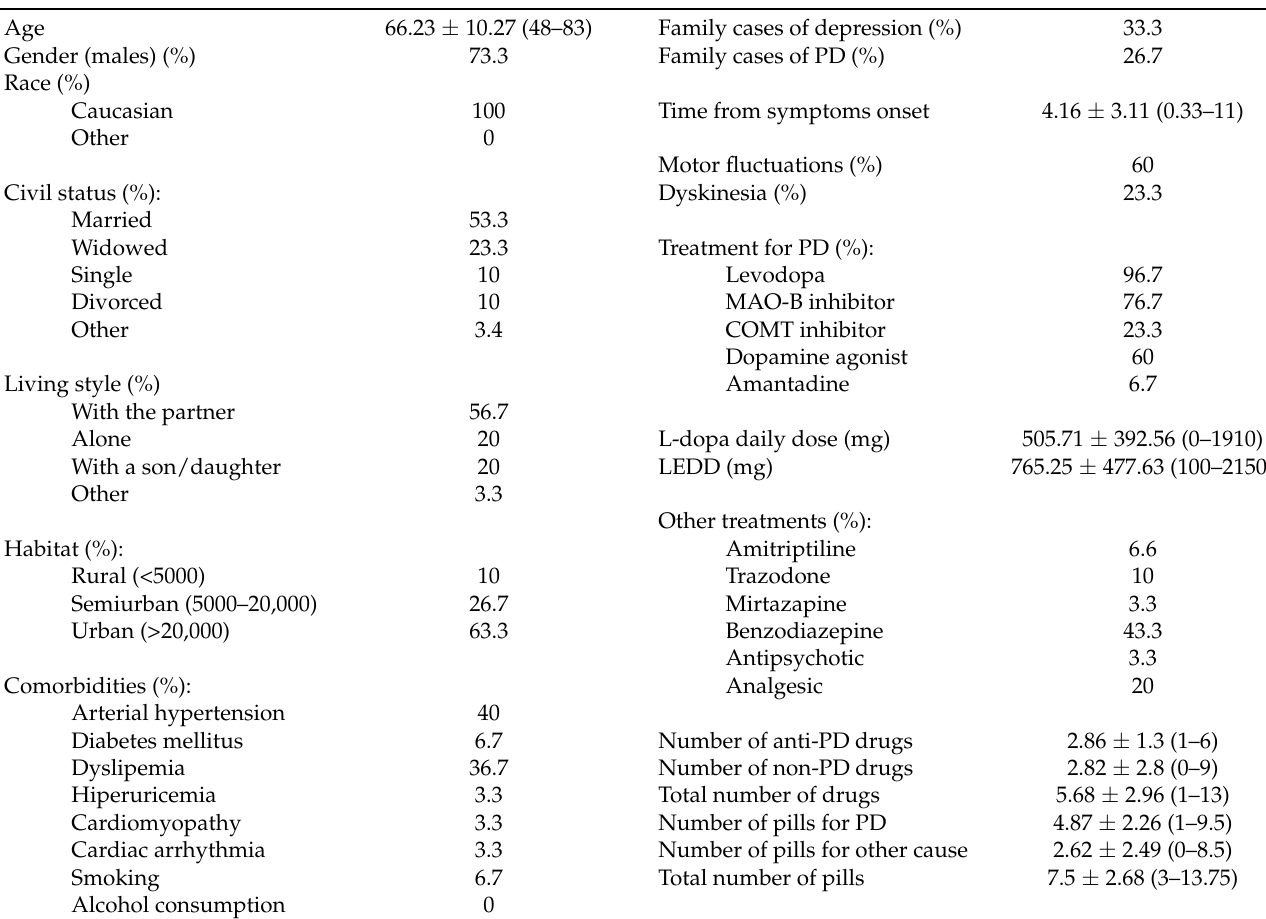
Table 1. Data about sociodemographic aspects, comorbidities, antiparkinsonian drugs and other therapies at baseline (N =